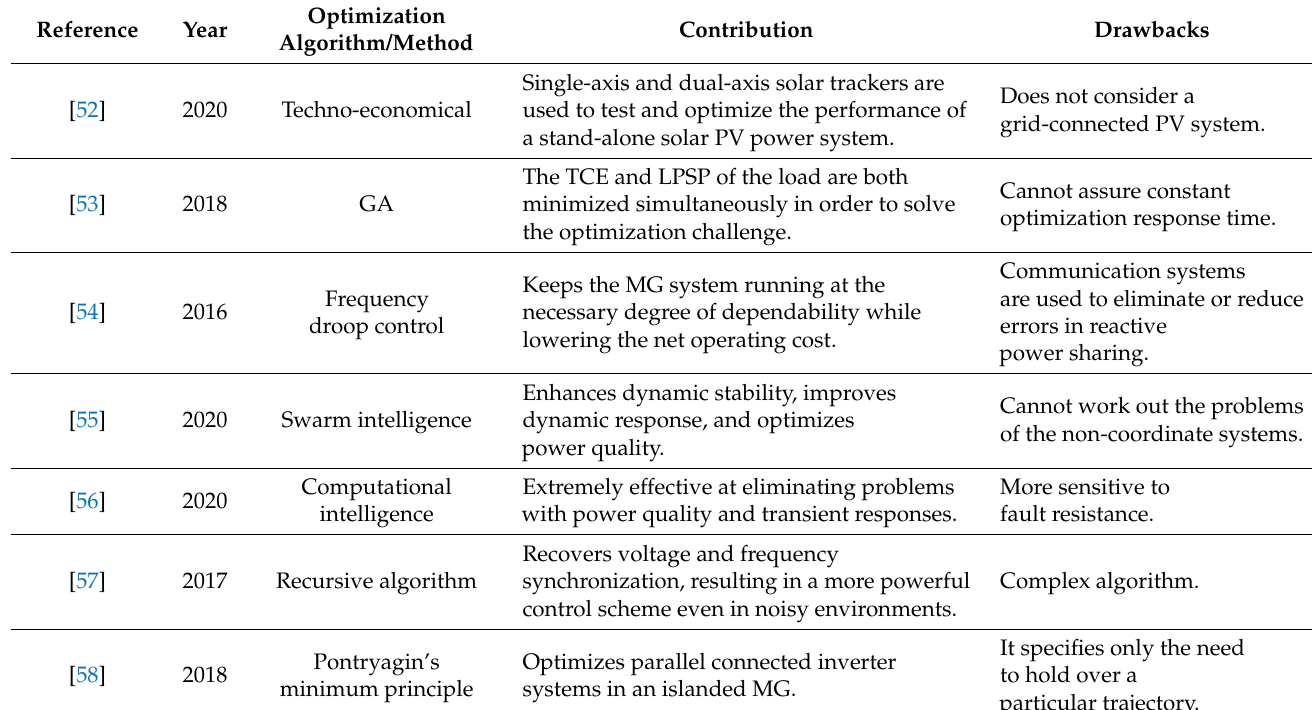
Table 5. Optimization methods in AC